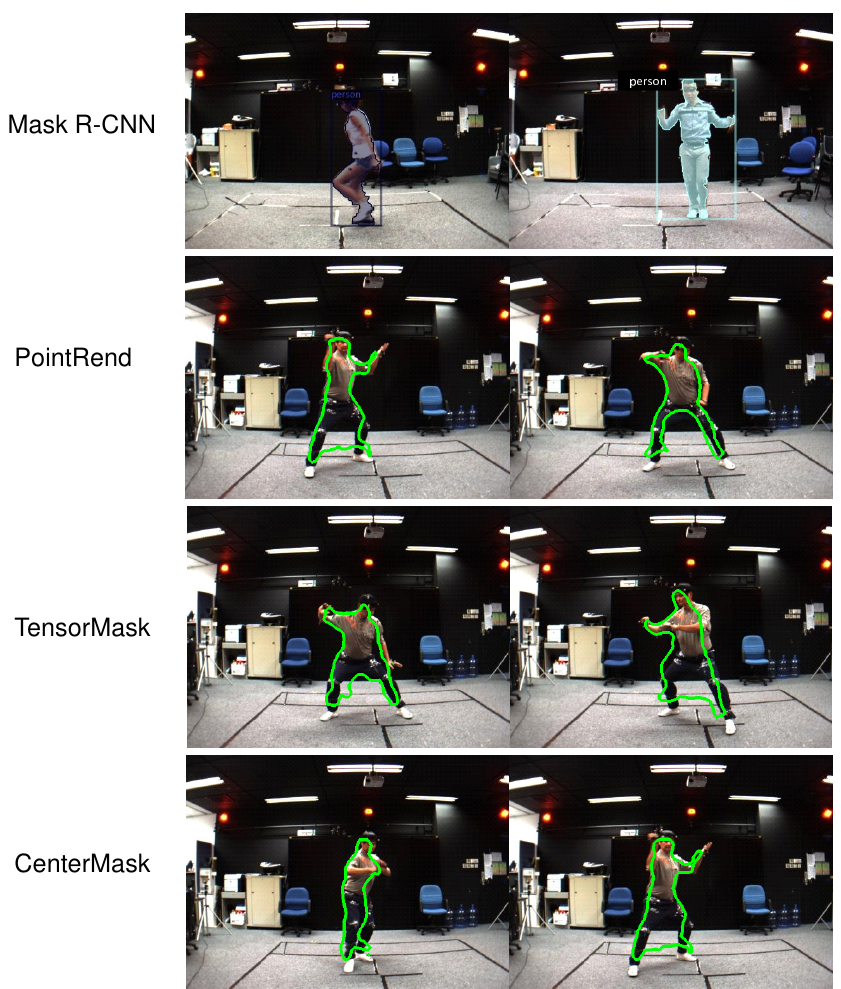
Figure 10. Examples of human segmentation results on the MADS dataset by CNNs.